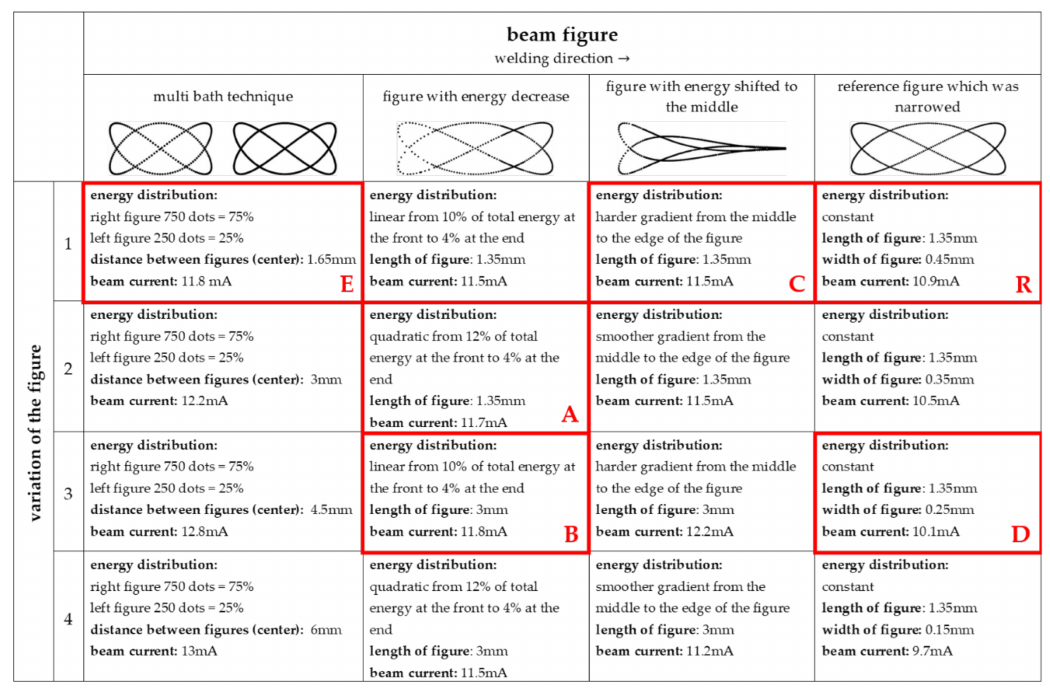
Figure A1. Test matrix from the first set of experiments. Marked in red are the six chosen figure configurations and their parameters which were applied in the second set of experiments.